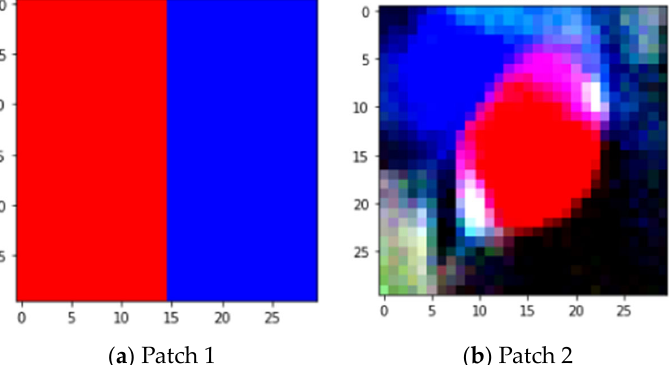
Figure 8. The color and cropped patch triggers are generated through image segmentation using HSV color space and OpenCV functions. These distinct triggers are more e ff ective than the original backdoor trigger.